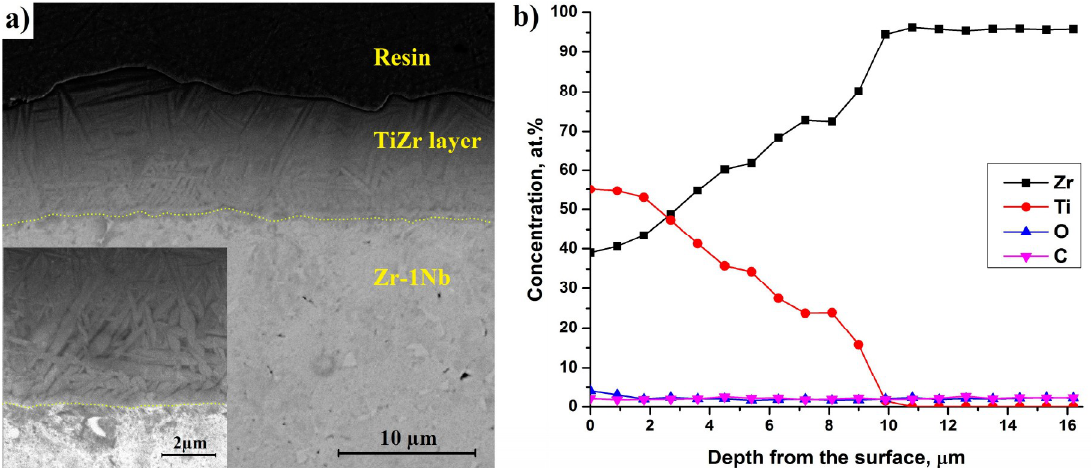
Figure 1. Cross-section scanning electron microscopy (SEM) image of ( a ) Ti-implanted Zr-1Nb and ( b ) depth distribution of elements measured by EDX.